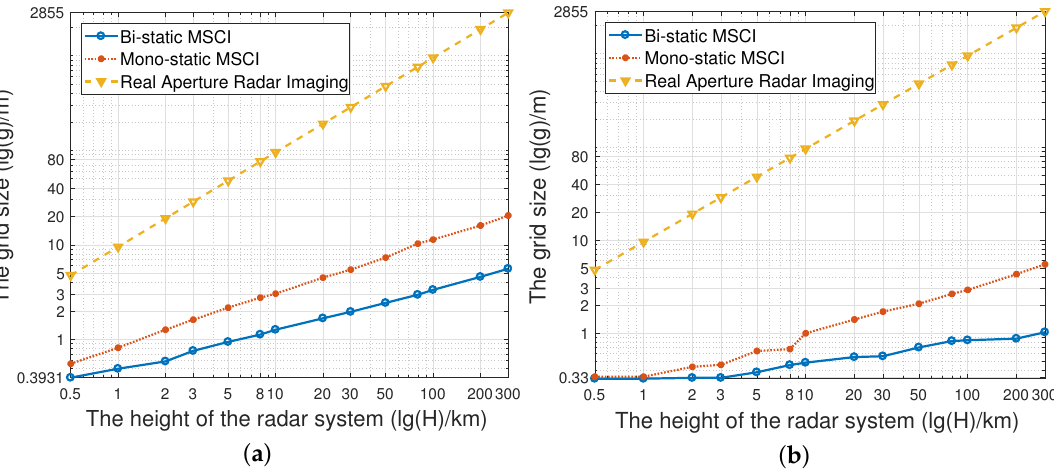
Figure 12. ( a ) The least grid size that satisfies the basic recovery of mono-static and bi-static MSCI under different imaging distances. ( b ) The least grid size that satisfies the accurate recovery of mono-static and bi-static MSCI under different imaging